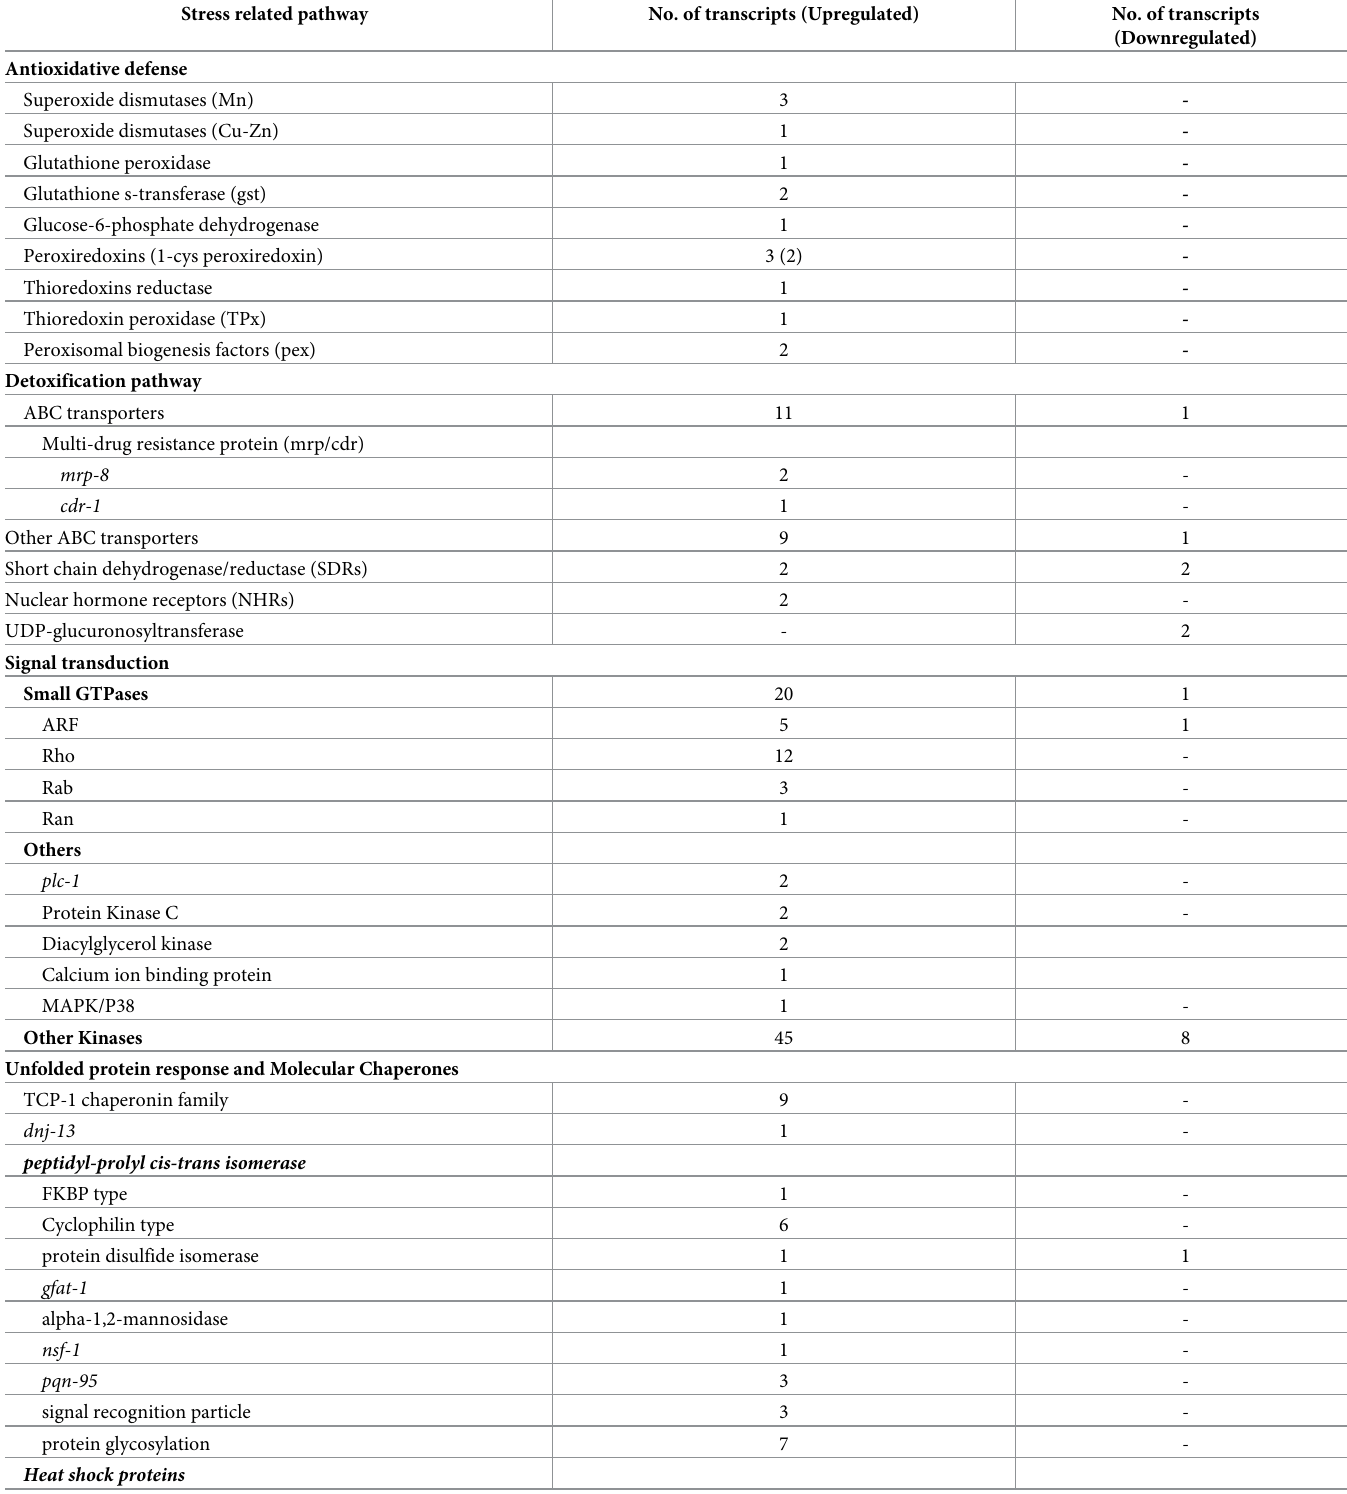
Table 1. Differentially expressed desiccation stress response transcripts identified in anhydrobiotic H . indica